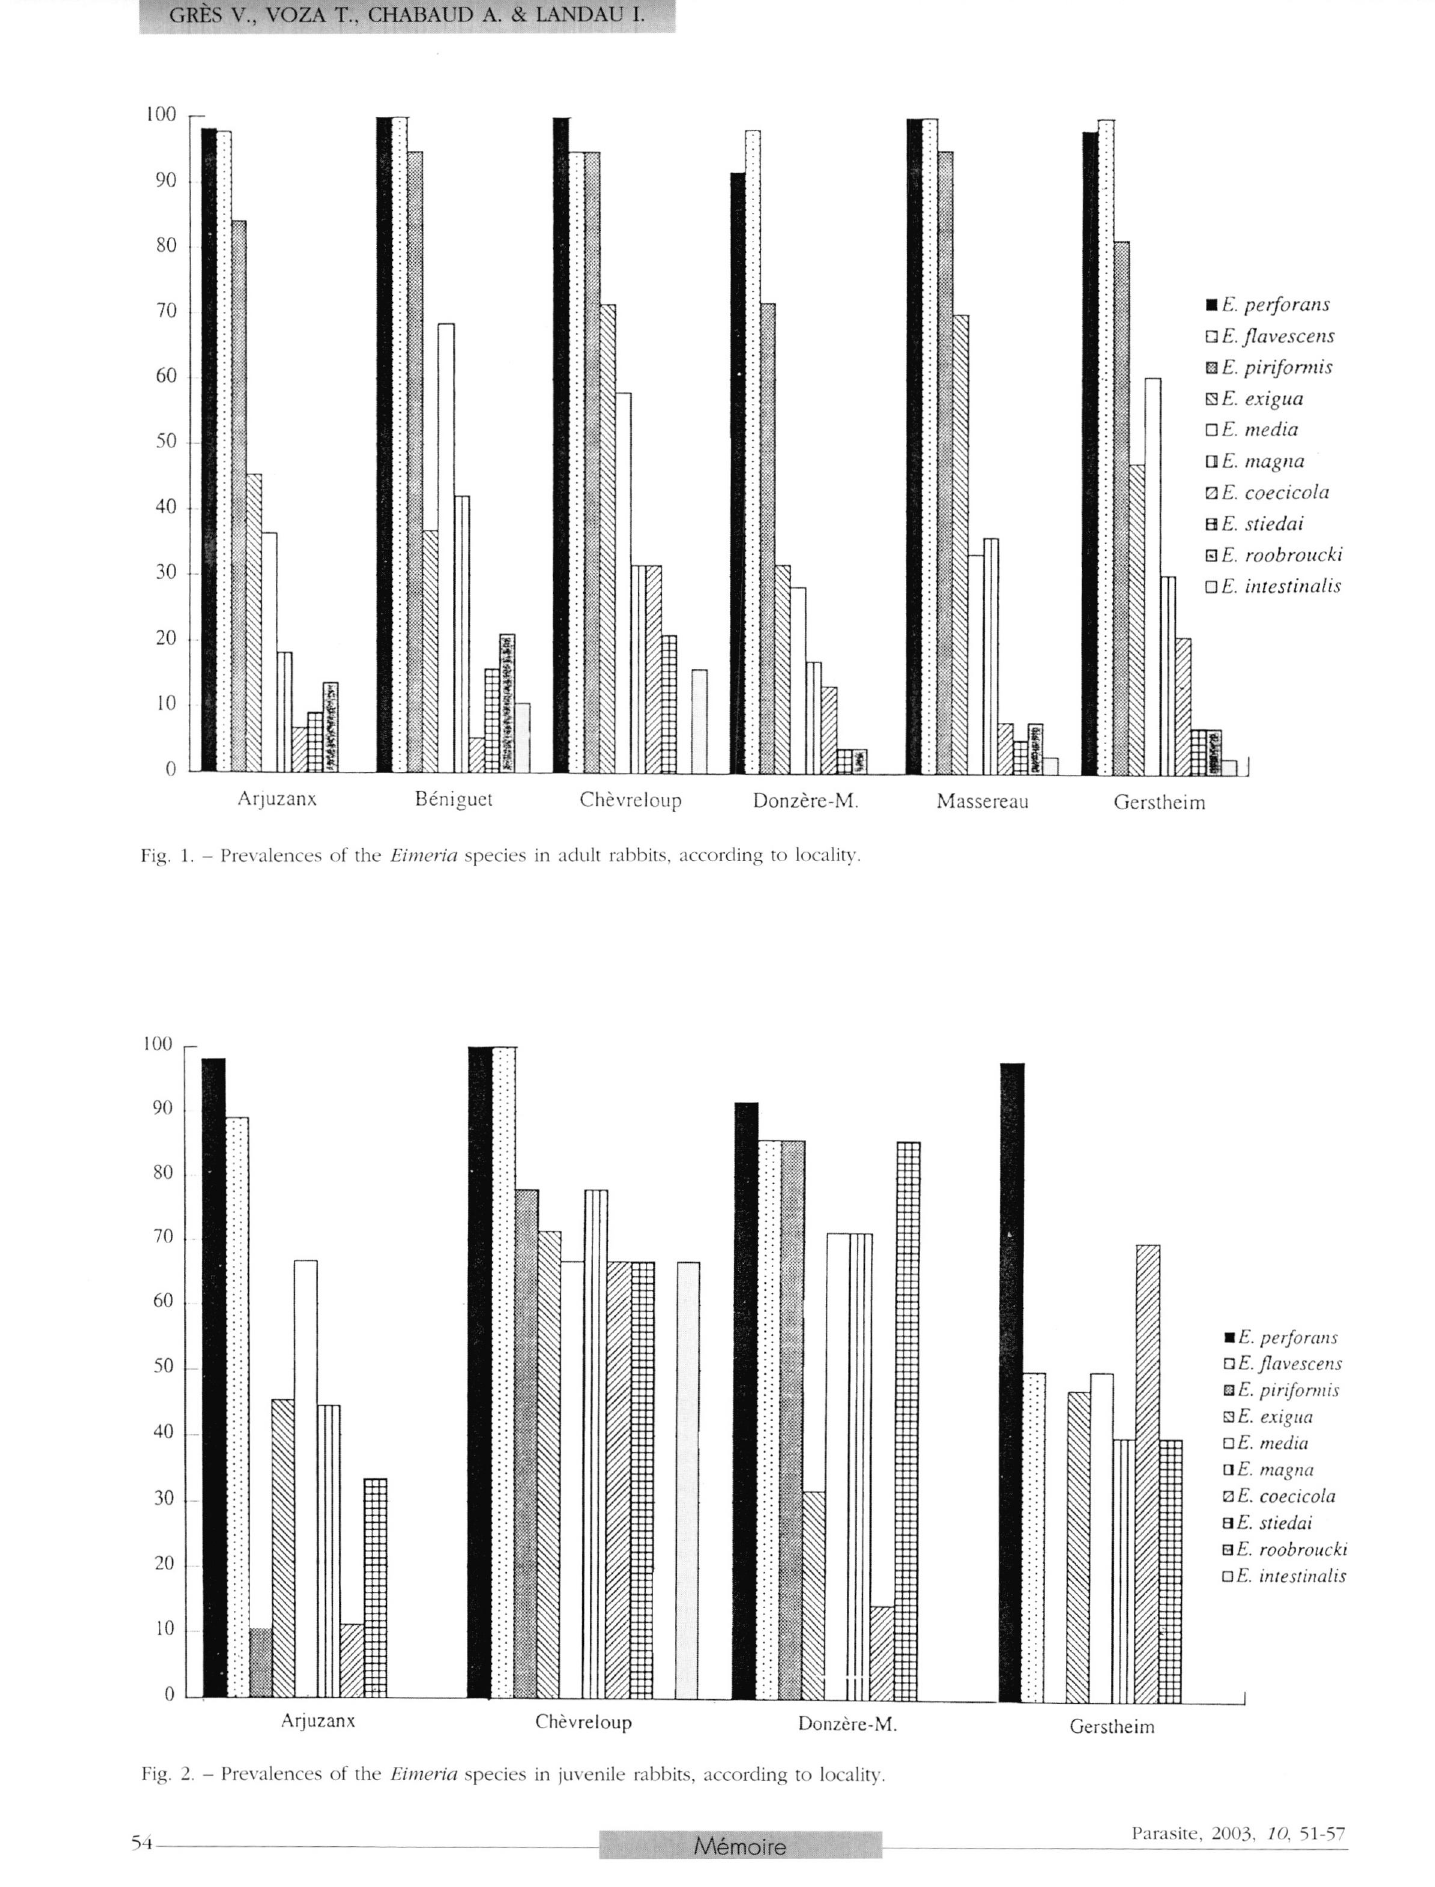
Fig. 2. - Prevalences of the Eimeria species in juvenile rabbits, according to